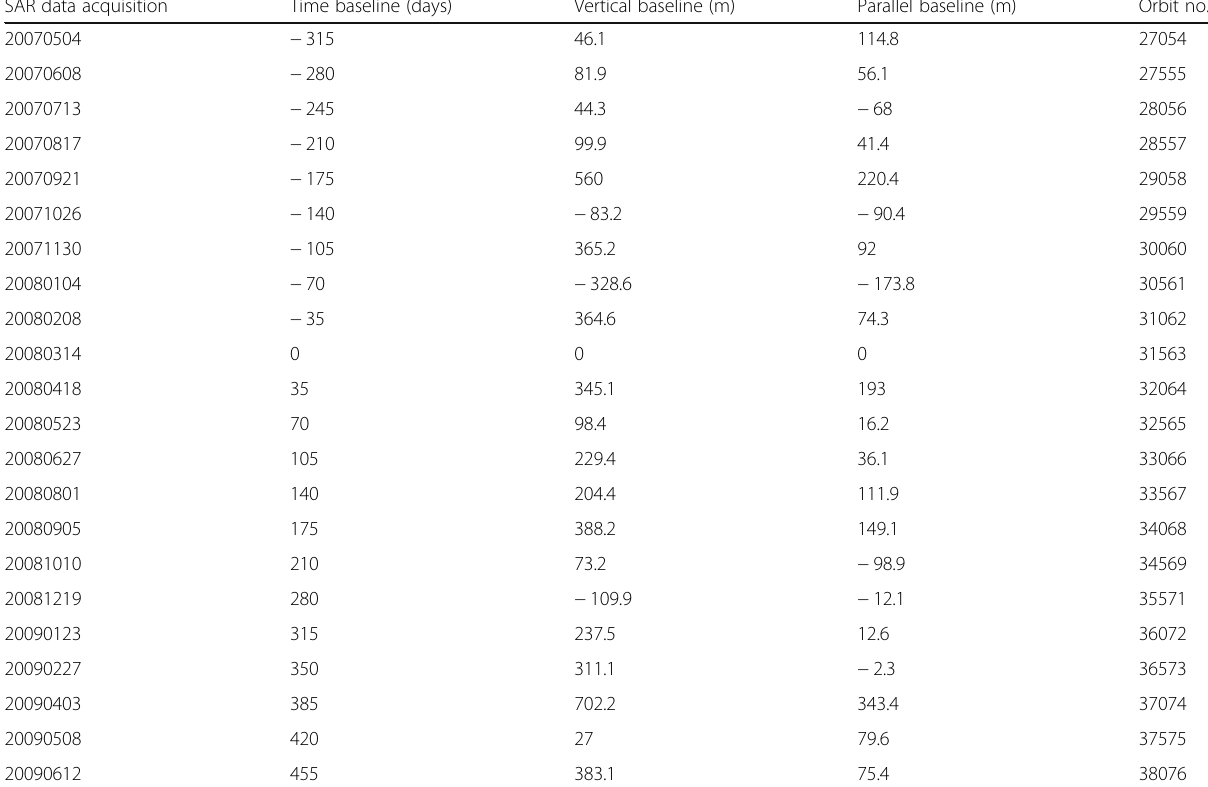
Table 1 SAR data source and time/space baseline (20080314 is the main image) SAR data acquisition